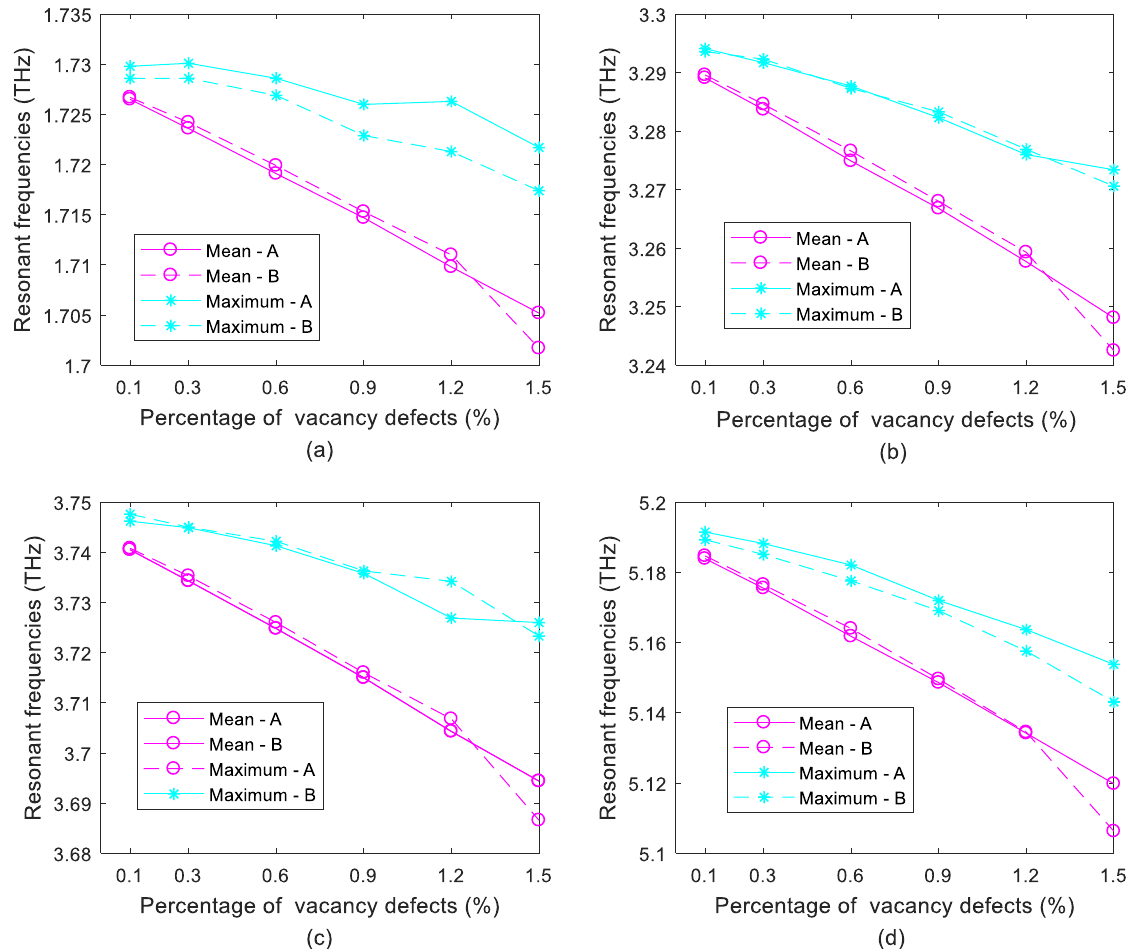
Figure 4. Comparison of atomic and bond vacancy defects ( a – d ) for the first- to fourth-order vibration modes; A and B represent the atomic and bond vacancy defects, respectively.